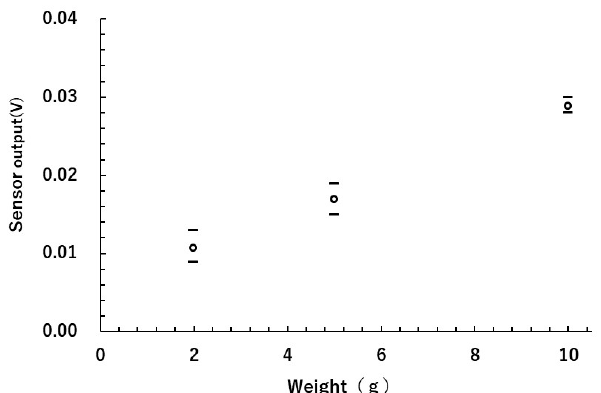
Figure 9. Output of a sensor when measuring using standard weights. Open circles are averages of 10 measurements and horizontal bars show the maximum and minimum values.